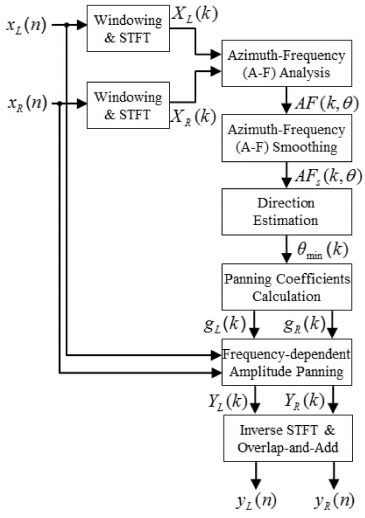
Figure 3. Block diagram of the proposed frequency-dependent amplitude panning for stereophonic image